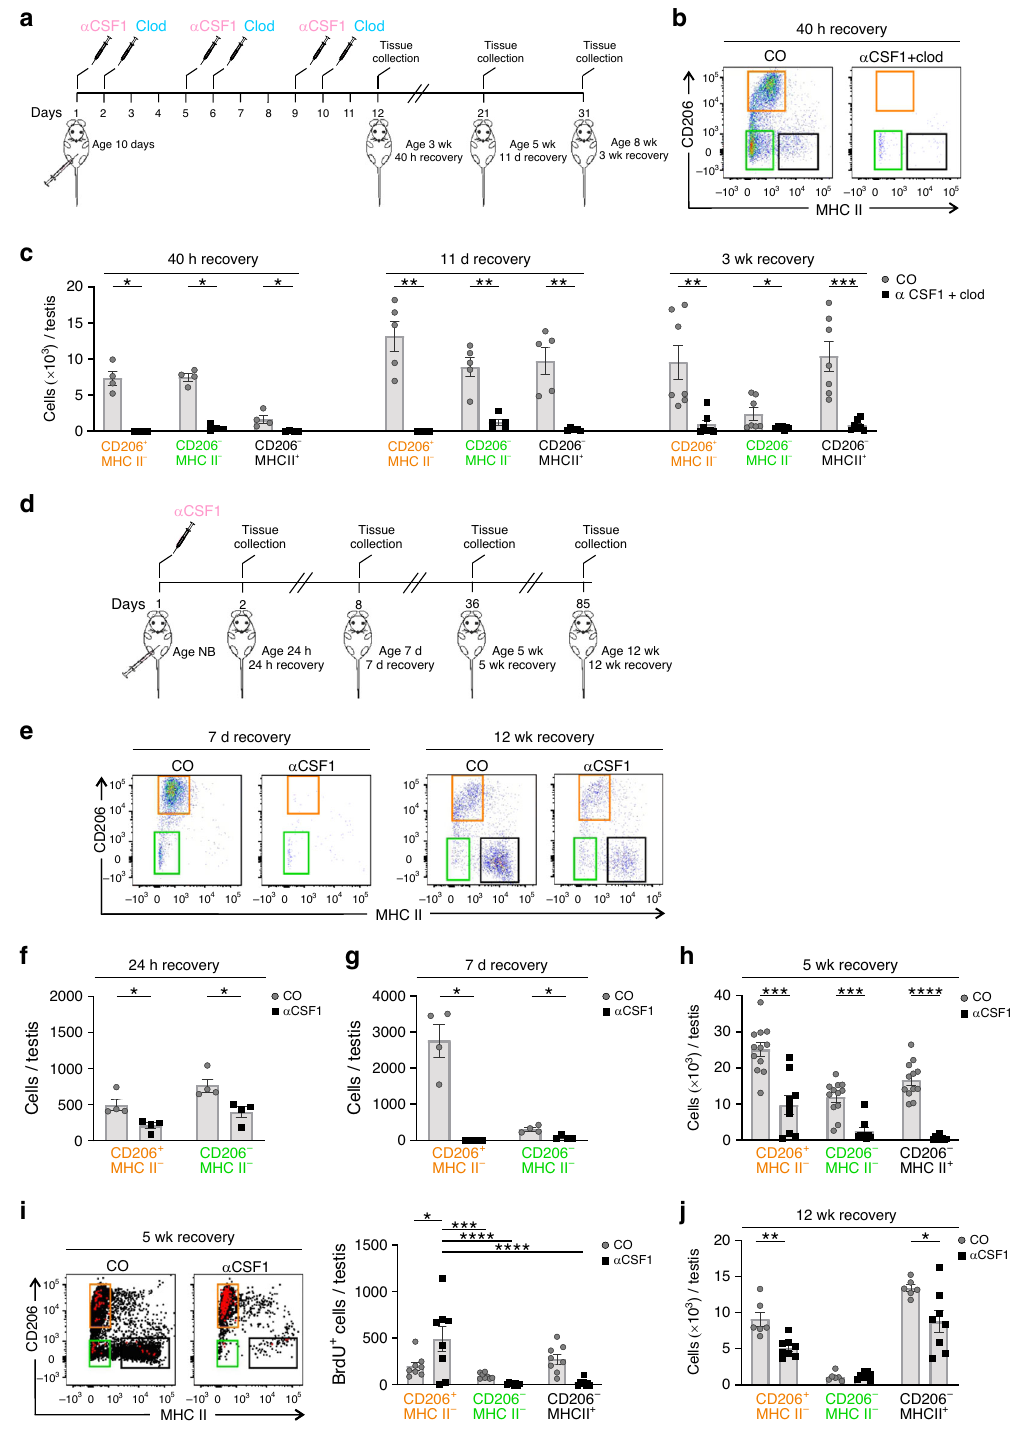
at this timepoint. The CD115 − CD206 − Ly6C Hi phenotype of these cells was strikingly different from the CD115 + CD206 + Ly6C − /Low phenotype of the yolk-sac-derived cells, and strongly suggested that they originated from fetal liver monocytes. The resistance of F4/80 Int cells against depletion of yolk-sac-derived cells and their lack of labeling in CSF1R- and CX3CR1 cell-fate mapping experiments veri fi ed their non-yolk sac origin. The discrepancy between the fi ndings of our study and a previous study is readily explained by the fact that only converted cells